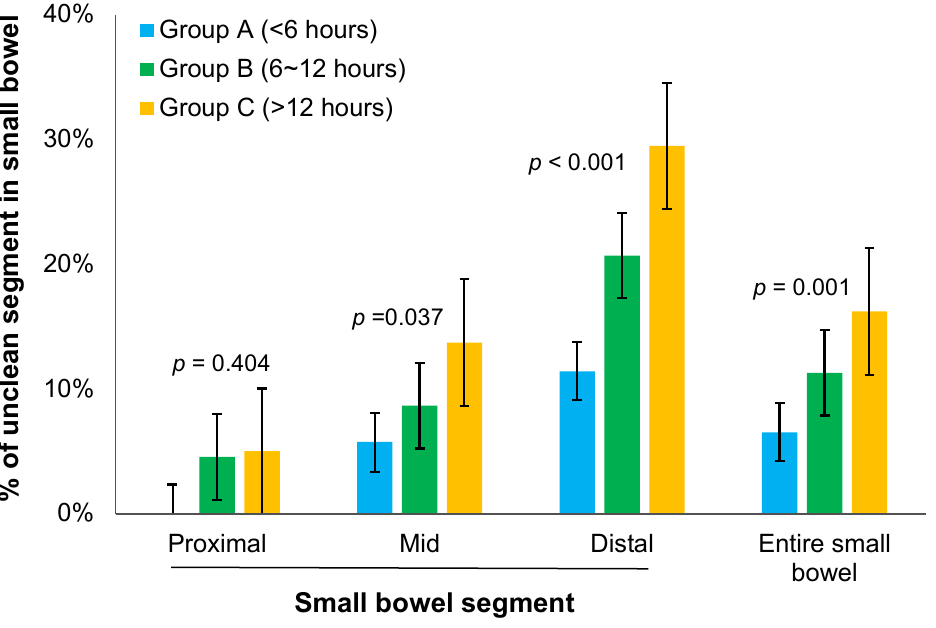
Figure 3. Percentage of unclean segment in the small bowel. According to the correlation analysis, the percentage of unclean segment of the small bowel steadily increased when the time interval between bowel preparation and capsule swallowing increased (correlation coefficient = 0.255, p = 0.015, Figure 4).